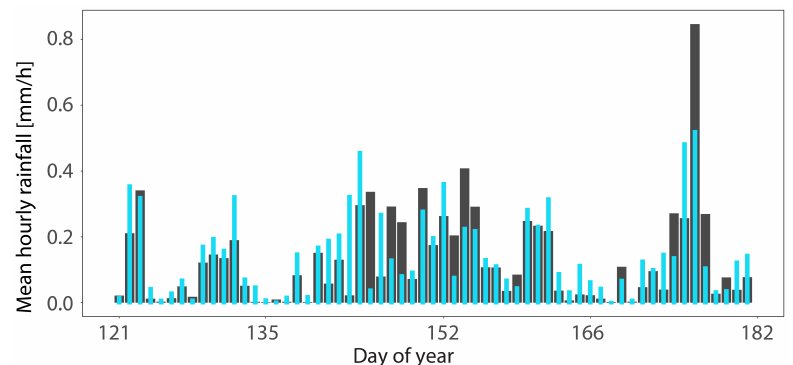
Figure 4. Mean daily rainfall intensities from observations (gray bars) and WRF model (cyan bars) calculated from hourly measurements gathered at all